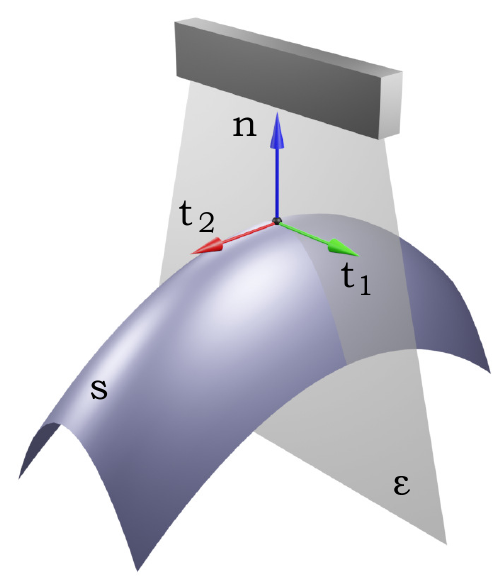
Figure 2. Surface normal n (blue arrow), tangent to first principal curvature t 1 (green arrow) and second principal curvature t 2 (red arrow) form an orthogonal system. The box shown above the surface s represents a line-shaped sensor. For linear phased array ultrasound, we claim that the long edge of the sensor should be parallel to the maximum